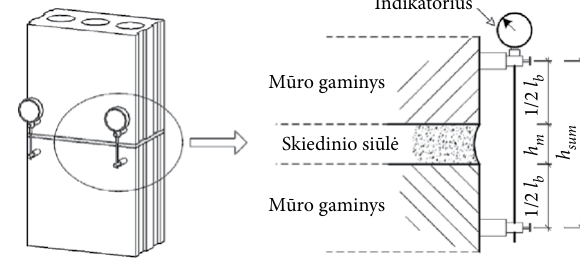
Fig. 8. The relationship of Poisson’s ratio and elastic modulus on axial compression of calcium-silicate prisms